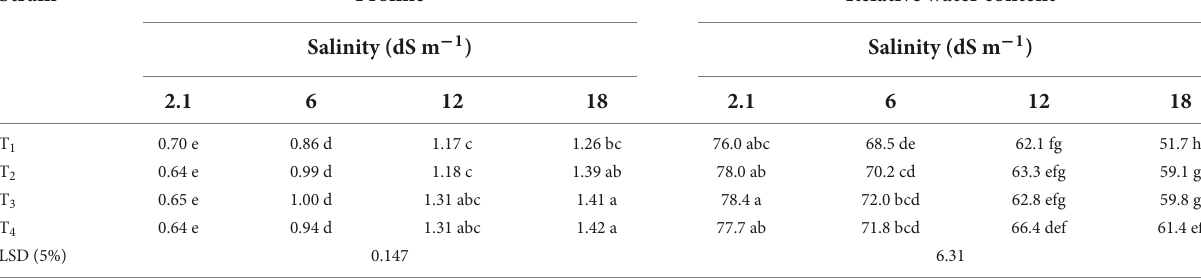
TABLE 7 Effect of inoculation with multi-strain bacterial consortium on proline ( µ mole g − 1 ) and relative water content of wheat at different salinity levels in a pot trial. Strain